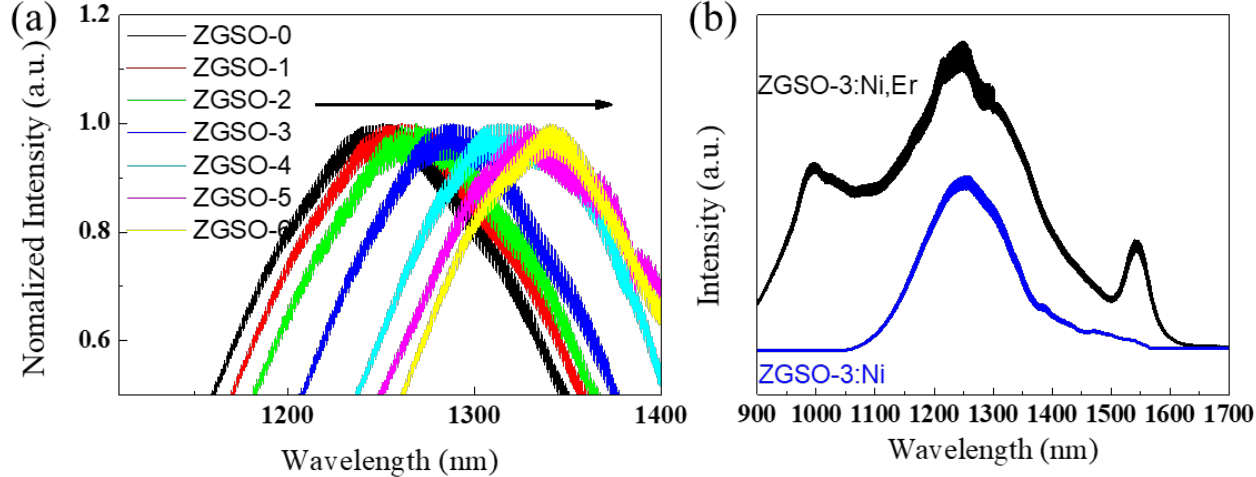
Figure 3. ( a ) PL spectra of 0.5% Ni 2+ -doped ZGSO-0 to ZGSO-6 samples. ( b ) PL of ZGSO-3:Ni 2+ (blue) and ZGSO-3:Ni 2+ Er 3+ (black). All samples were excited using a 365 nm UV lamp.